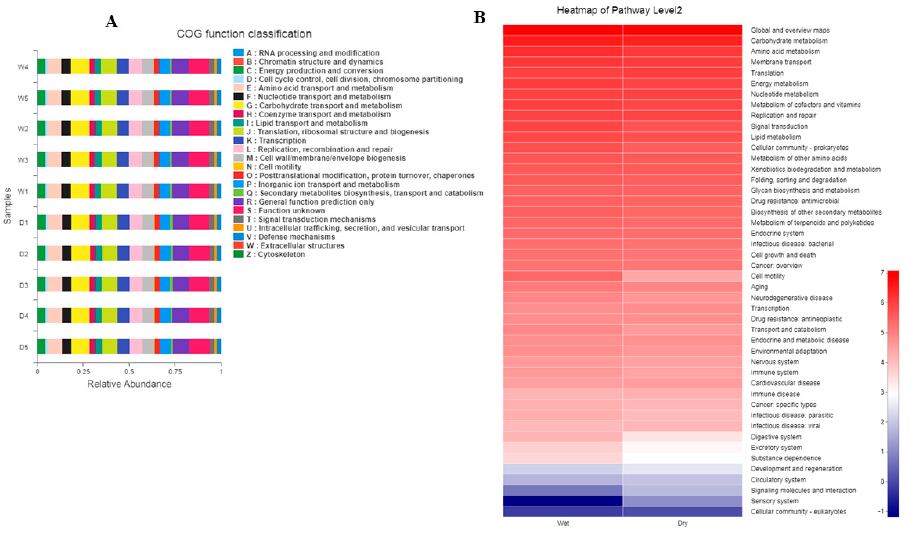
Figure 4. ( A ) CO Functional Classification; ( B ) KEGG Heatmap.